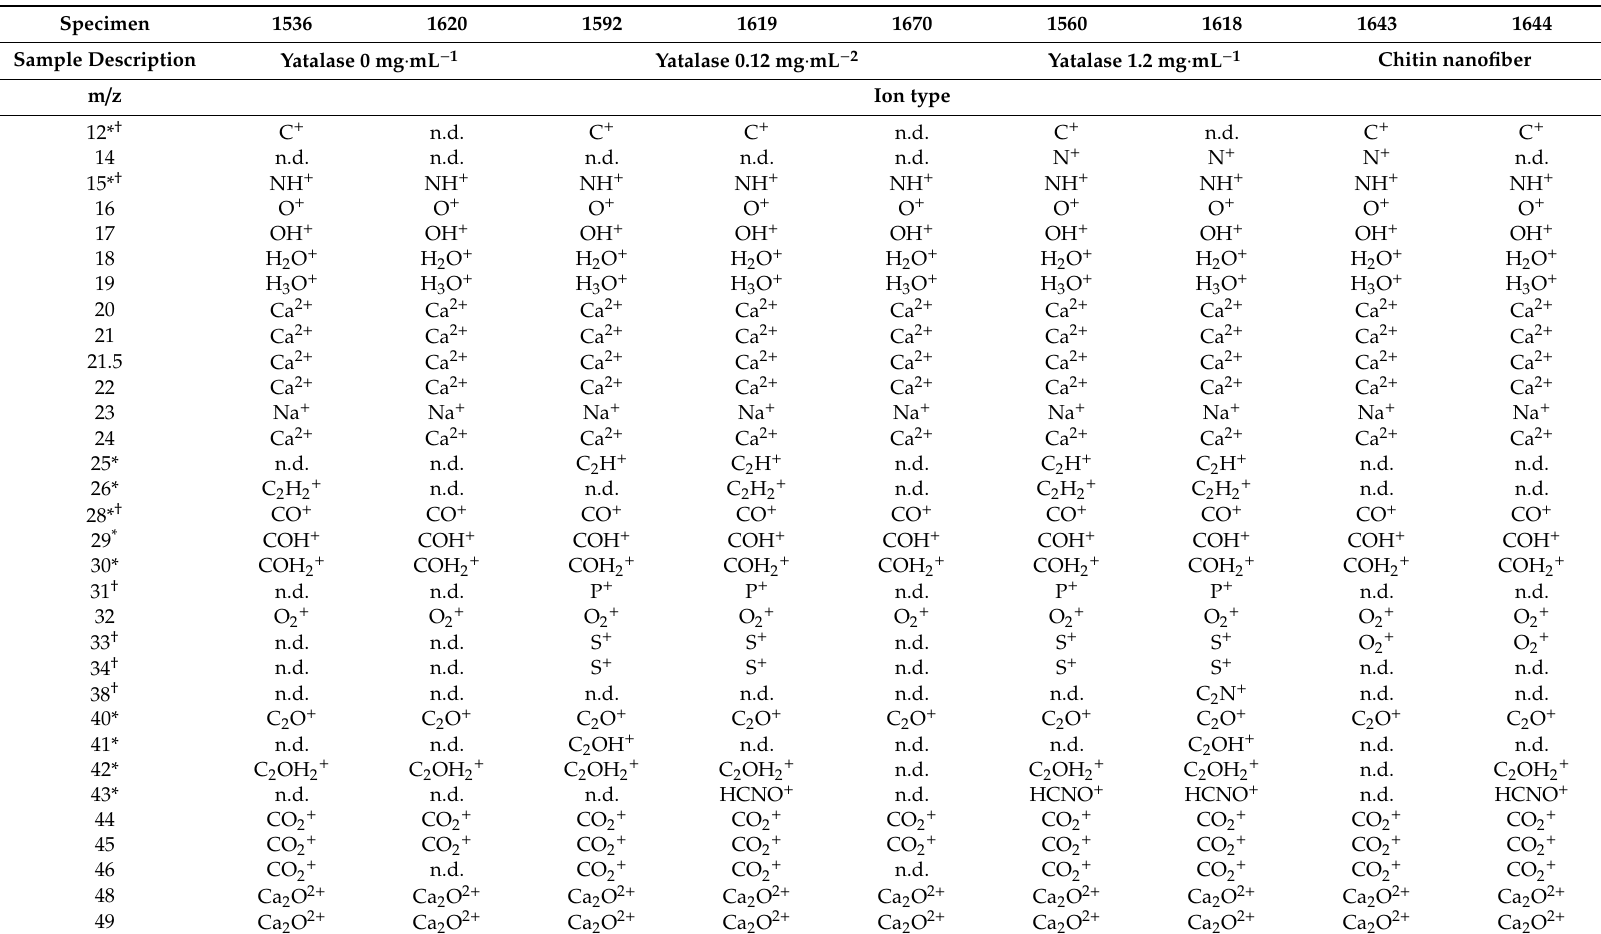
Table 2. Mass-to-charge ratio peak